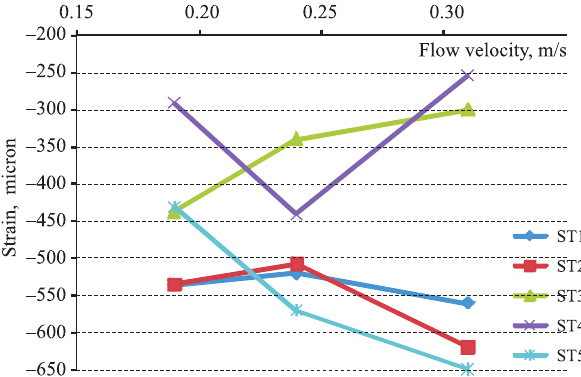
Fig. 16. Effect of flow velocity on slab strain when the load was located at mid-span